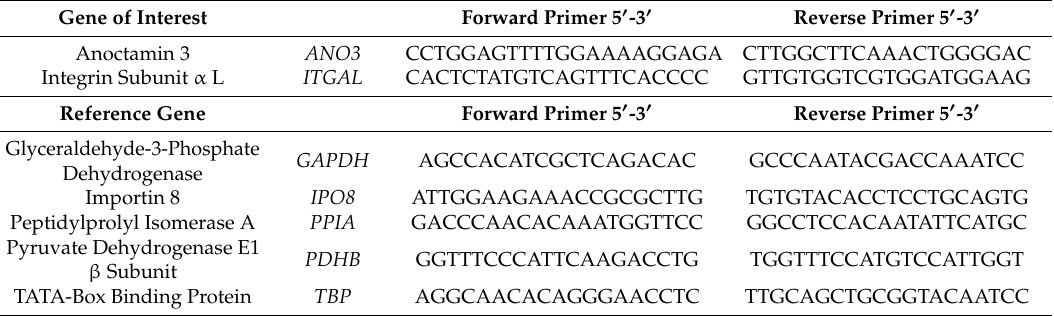
Table 3. qRT-PCR was performed on a 7500 Fast instrument (Applied Biosystems), using a standard program for relative quantification: 50 cycles of denaturation at 95 ◦ at 60 C for 1 min, terminated by a melting curve. Table 3. Primers used for gene expression